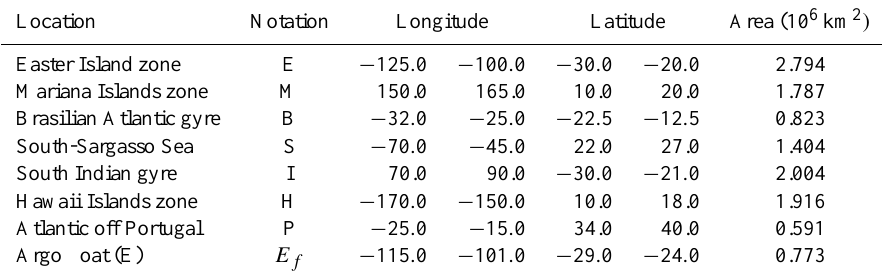
Table 1. Geographical information for the six oligotrophic zones selected for the present study (see also map in Fig. 1); in addition, are included a mesotrophic site off Portugal, used for comparison (see text), as well as a sub-zone near Easter Island, denoted E f , where an Argo float has been deployed during about 3